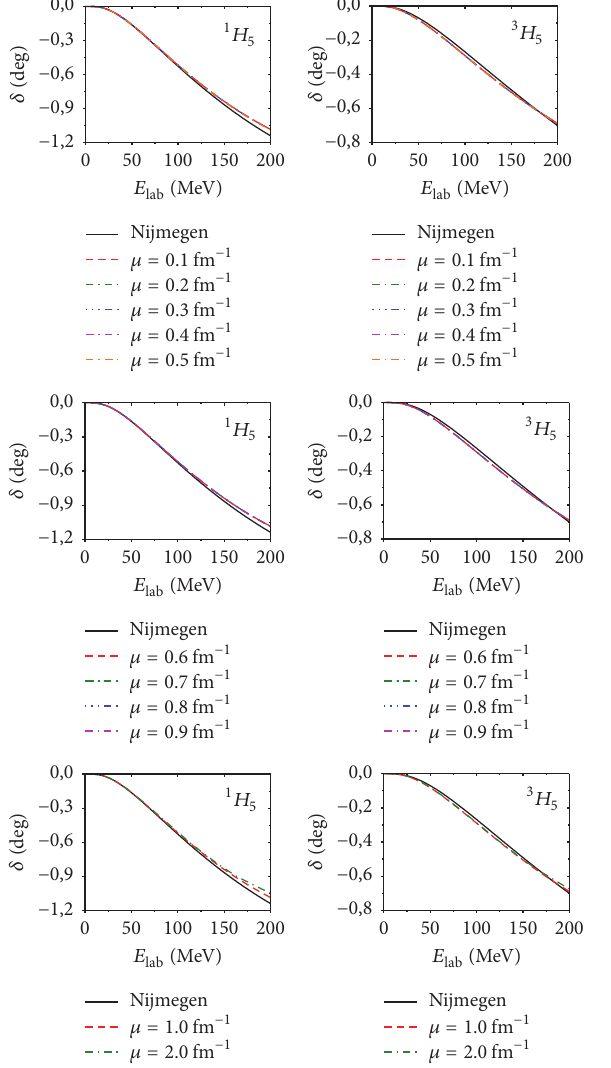
Figure 10: (Color on-line) phase shifts in 1 𝐼 6 and 3 𝐼 6 channels calculated from the solution of the subtracted LS equation for the 𝐾 -matrix with five subtractions for the N3LO-EGM potential for several values of the renormalization scale compared to the Nijmegen partial wave analysis.